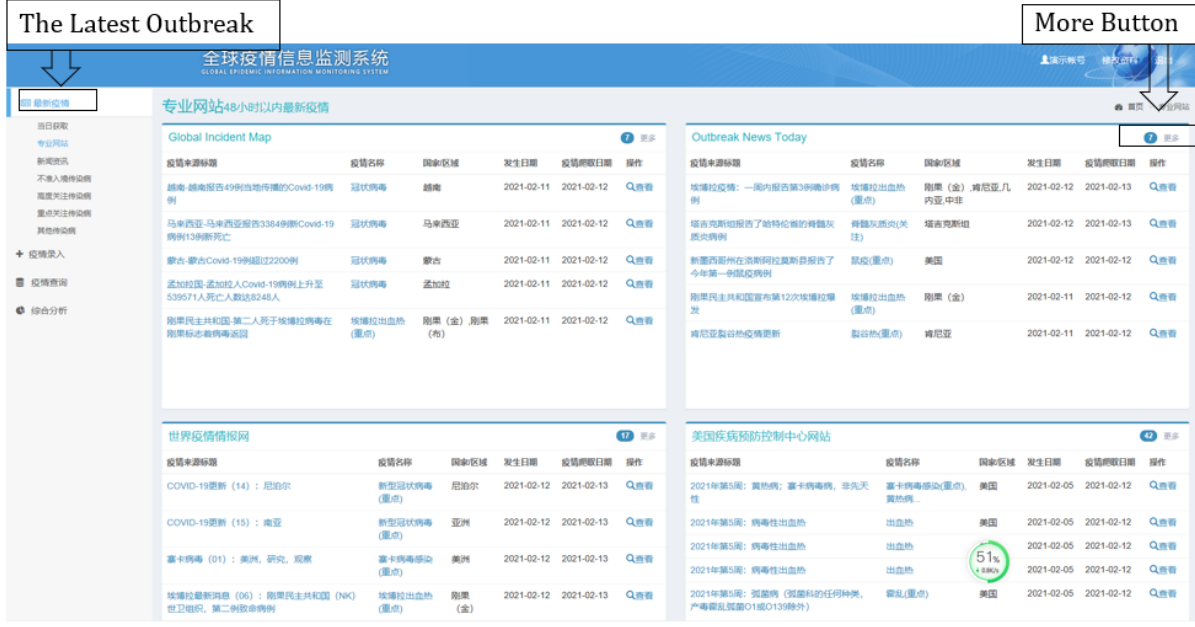
Figure 3. First page of the Global Infectious Diseases Epidemic Information Monitoring System, showing the latest outbreak.